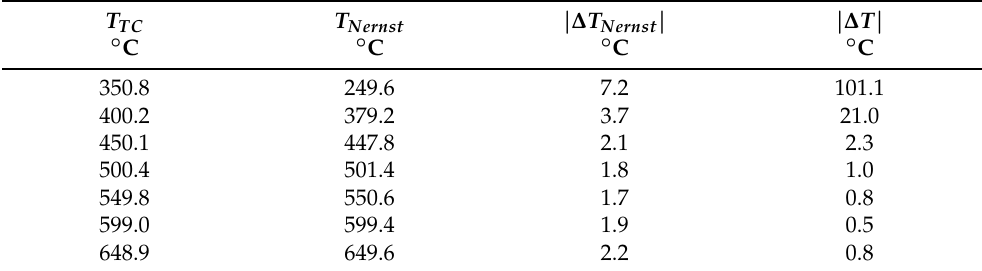
Table 1. Comparison of temperatures obtained from thermocouple measurement in close proximity to the sensor with values derived from sensor